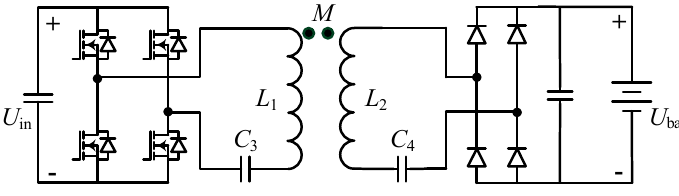
Figure 7. The circuit topology with SS compensation.